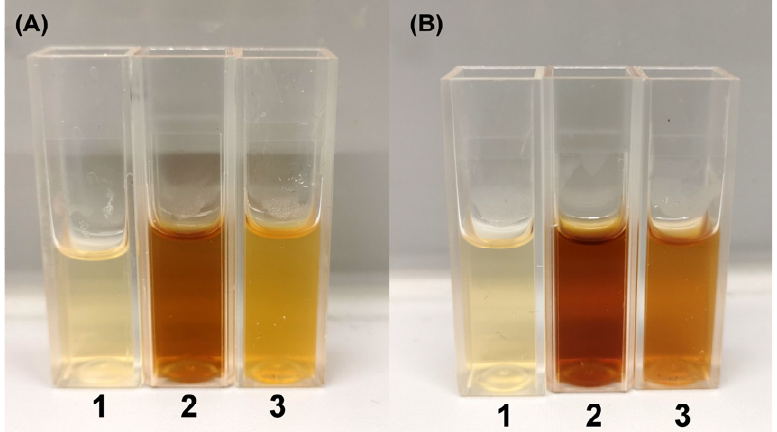
Figure 4. The evaluation of AgNP formation using Geobacillus spp. bacterial secretomes after 24 h ( A ) and 48 h ( B ). 1—bacterial growth medium without Geobacillus spp. cells supplemented with 2 mM of AgNO 3 ; 2—strain 95 secretome supplemented with 2 mM of AgNO 3 ; 3—strain 612 secretome supplemented with 2 mM of AgNO 3 .